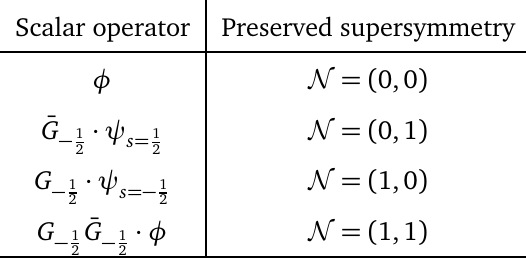
Table 3: Operator deformations in an N = ( 1,1 ) SCFT. Here, φ